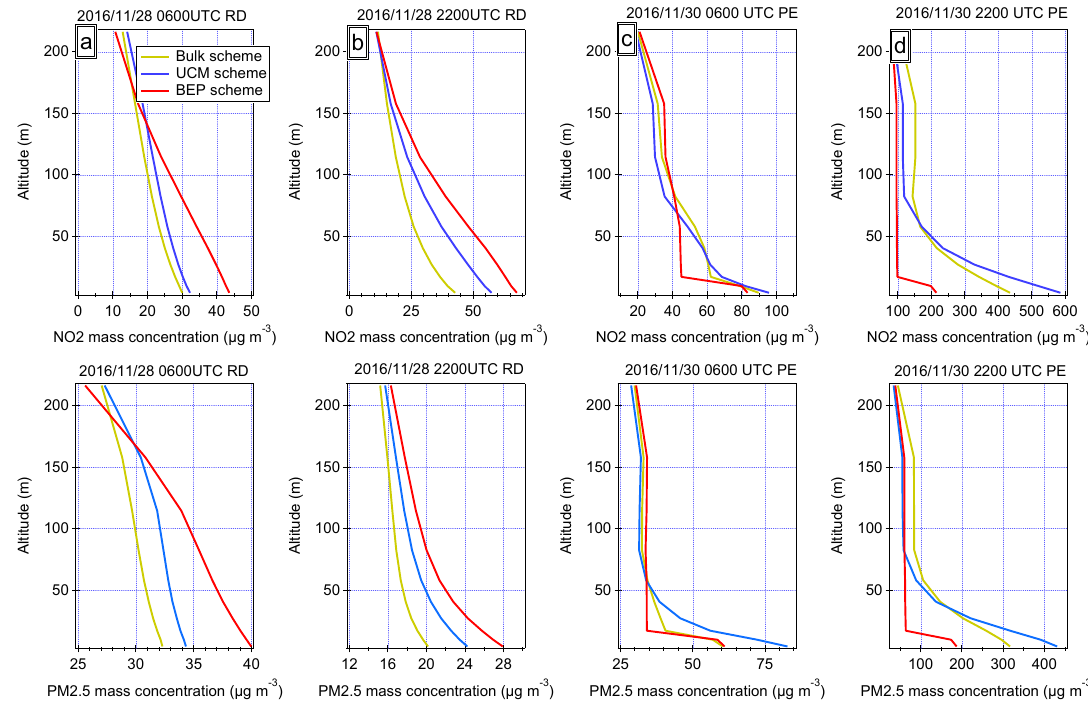
Figure 13. Vertical profiles of the NO 2 and PM 2.5 mass concentration ( µ g m − 3 ) at the FR04143 station. The profiles are extracted at 06:00 and 22:00 UTC for both Regular Days (RD) and the Particulate Episode (PE). Columns ( a ), ( b ), ( c ), and ( d ) represent the vertical mass concentration of NO 2 and PM 2.5 at 28th November 06:00, 28th November 22:00, 30th November 06:00, and 30th November 22:00 UTC,